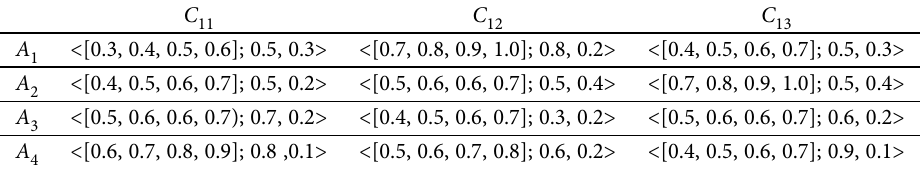
Table 1. Decision-making matrix